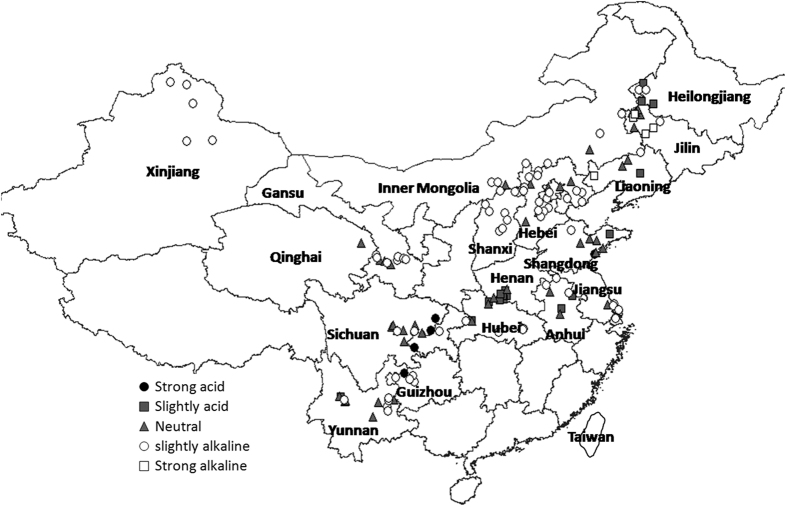
Map of classification of soil pH in food legumes growing areas, Greater China.Created by DIVA_GIS (v7.5) software. Hijmans, R.J., Guarino, L., Mathur P. DIVA-GIS. Version. 7.5. http://www.diva-gis.org/ (2012) Data of access: 05/07/2015.